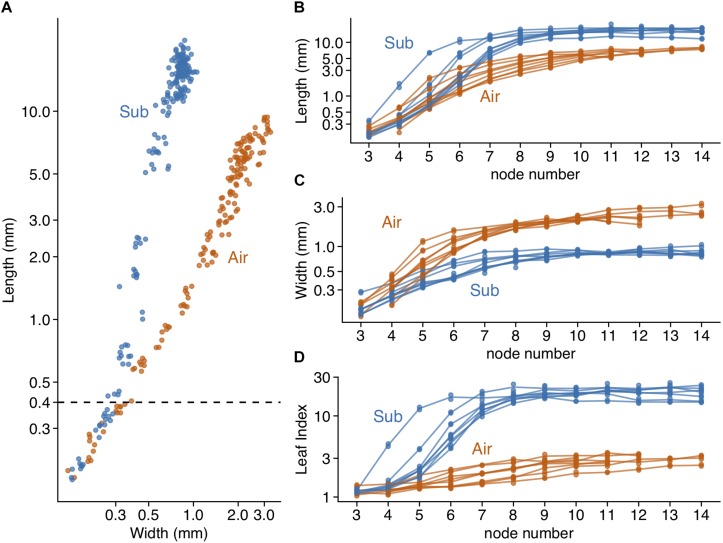
Changes in leaf form during development. (A) length-width plot of developing leaves from eight aerial and eight submerged shoots. 164 aerial leaf primordia and 188 submerged leaf primordia are shown as points. (B) leaf length, (C) Leaf width, and (D) leaf index are plotted with node numbers. Lines connect the mean values of pairs of leaf primordia in the same shoot and each point indicates the value of an individual leaf primordium.